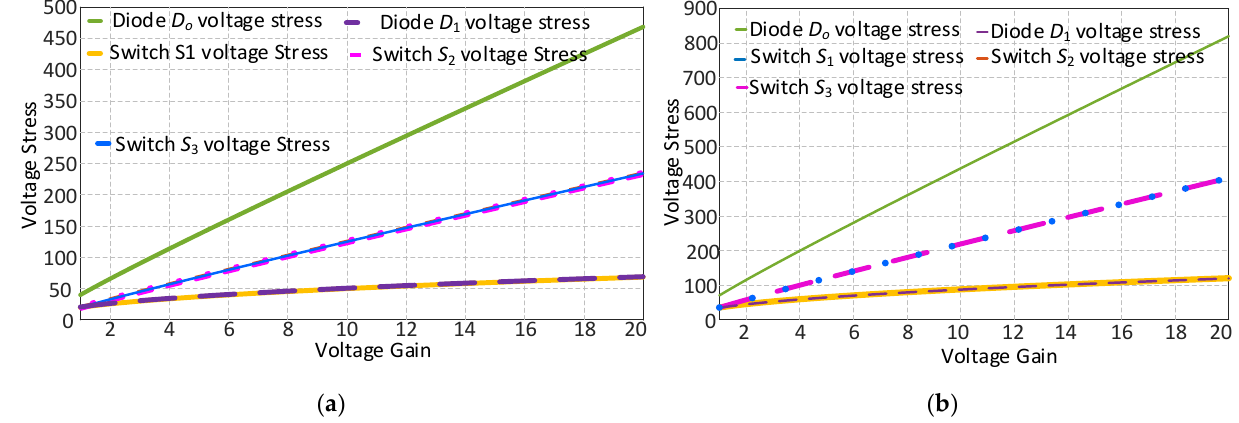
Figure 6. The component voltage stress vs. voltage gain at an input voltage of ( a ) 20 V; ( b ) 35 V.